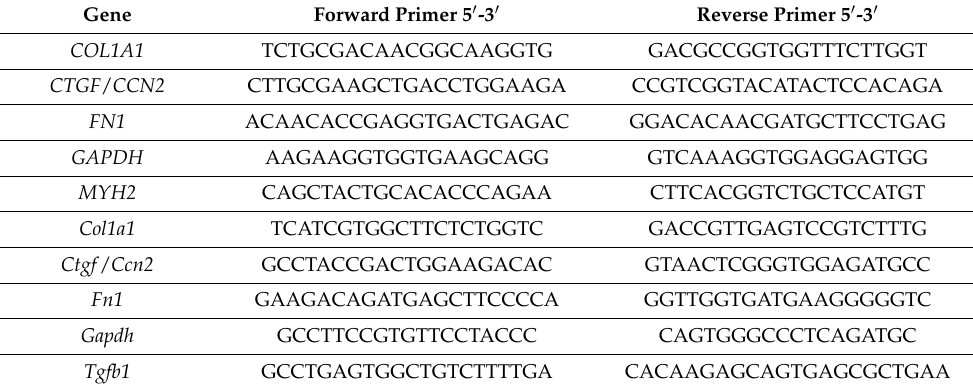
Table A3. List of primers used in real-time